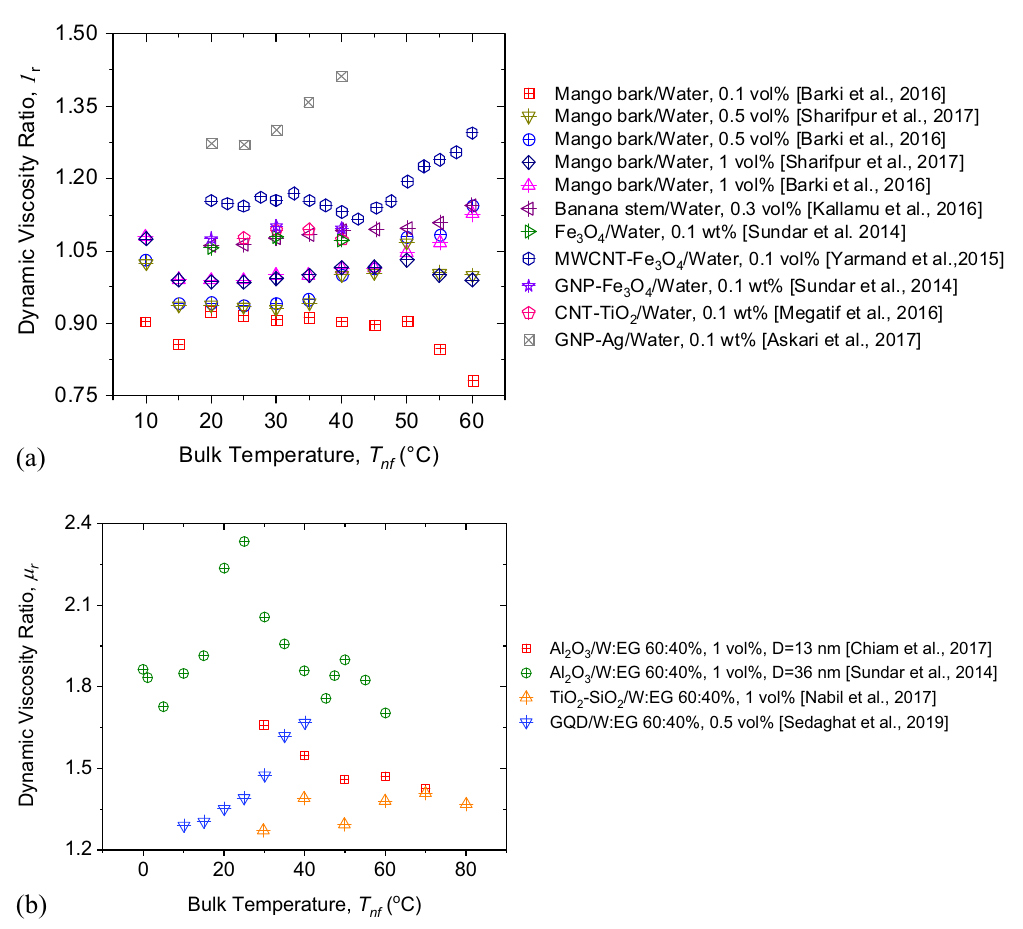
Figure 9: E ff ect of bulk temperature on normalized dynamic viscosity: ( a ) water and ( b ) W:EG